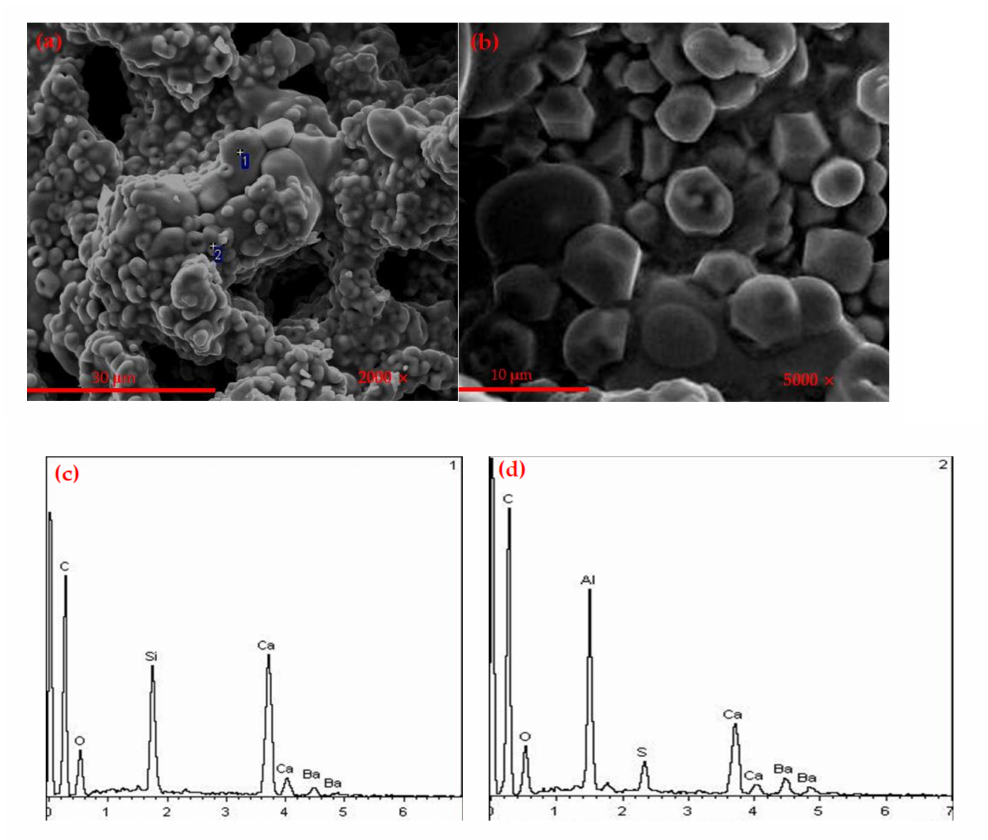
Figure 3. SEM-EDS micrographs of ( a , b ) CAF 1 clinker, ( c ) 1-EDS, ( d ) 2-EDS. Figure 4 is the SEM-EDS of the barium calcium sulfoaluminate cement clinker